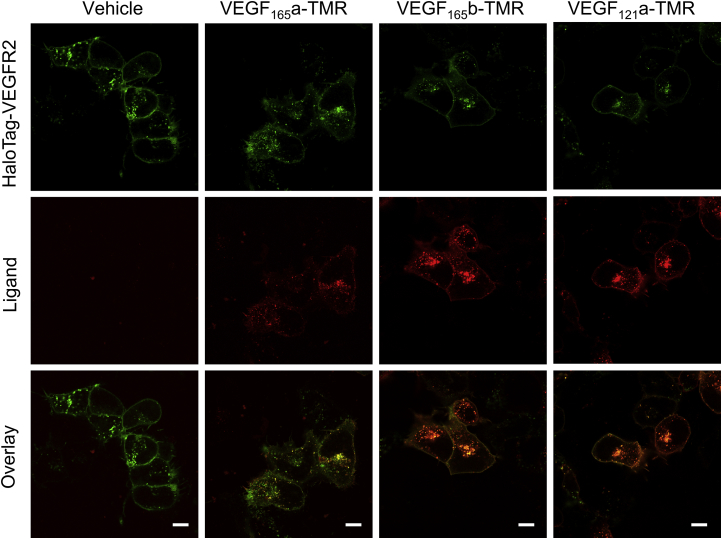
Co-localization of Fluorescent VEGF-A Isoform Binding and HaloTag-VEGFR2Confocal images of HEK293T cells stably expressing HaloTag-VEGFR2 (green) stimulated with vehicle or 10 nM VEGF165a-TMR, VEGF165b-TMR, or VEGF121a-TMR (red) for 1 hr at 37°C. Cells were imaged live using a Zeiss LSM710 and are representative images of 3 independent experiments. Scale bar, 10 μm. See also Figures S3 and S4.